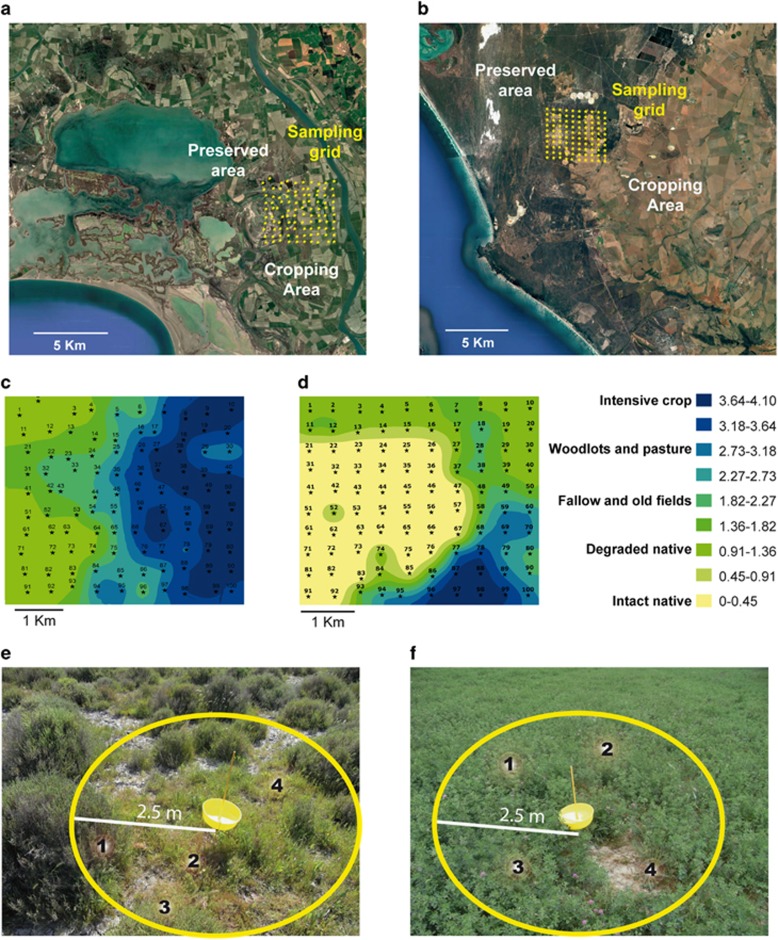
French and South African sampling designs. (a) French and (b) South African sampling sites. Both 4.5 × 4.5 km2 sampling grids contained 100 GPS-nodes with 500 m spacing and were located across agro-ecological interfaces between cultivated and uncultivated areas. Spatial interpolation of degrees of human-mediated disturbance at the (c) French and (d) South African sampling sites. Empirical Bayesian Kriging was performed based on scores depicting the level of intensity of agriculture using ArcGIS to visualise interfaces between uncultivated and cultivated areas. Every sampling point was ranked as follows: (0) intact native communities; (1) native communities degraded by disturbance or invasion; (2) fallow and old fields; (3) low-intensity polyculture (woodlots and pasture); and (4) intensive crop monoculture. (e, f) Examples of two geo-nodes at the French sampling site. (e) exemplifies an uncultivated sampling point at which four plants (numbers 1–4), each within 2.5 m of the geo-node and with a biomass >10 g, were considered ‘dominant’ and sampled. (f) exemplifies a cultivated sampling point, in this case where the vegetation is dominated by alfalfa, at which we collected three separate 5- g alfalfa samples (numbers 1–3) and one (number 4) from a dominant (that is, >10 g biomass) weed.